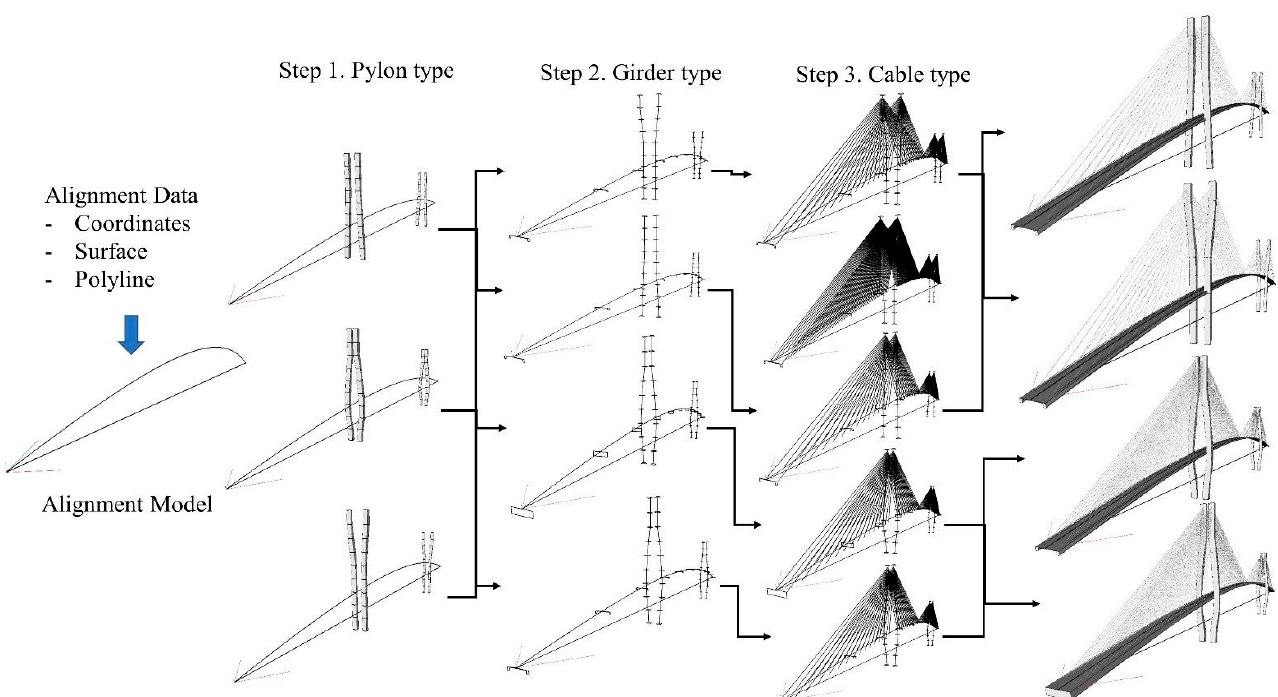
Figure 6. Modeling algorithms for concept design process.